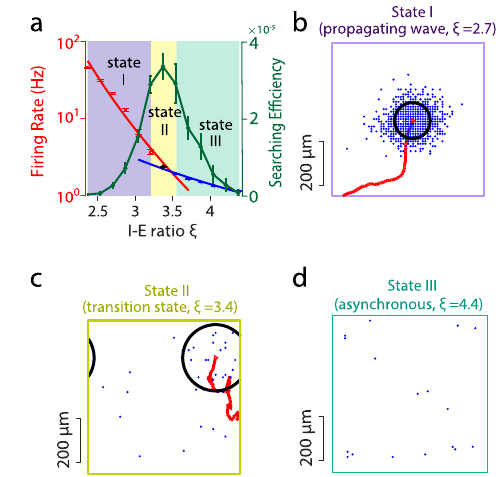
Fig. 4 Emergent network activity in a neural circuit model. a Mean fi ring rate of the population of excitatory neurons in the model shows a phase transition around an I-E ratio of 3.4. The red and blue lines are two power functions fi tted to the data points marked by red squares and blue circles, respectively. The black dot denotes the crossing point of the two power-law functions. The green line shows the change of the searching ef fi ciency with different I-E ratios. Error bars show SEM. Three distinct states emerging from the circuit are marked by different colors; State III corresponds to the asynchronous state, State I exhibits localized propagating wave patterns and State II is the transition region. b – d Snapshots of neural spiking patterns emerging from the circuit model with different I-E ratio values. Blue dots denote spikes emitted by excitatory neurons during a 5 ms period. Black circles in ( b ) and ( c ) show one standard deviation of the 2D normal fi tted fi ring rate. Red curves show trajectory of the pattern in the previous 100 ms. For State I in ( b ), the spiking patterns propagate smoothly. For State II in ( c ), the pattern appears intermittently and exhibits variable propagation trajectories. For State III (the asynchronous state) in ( d ), no patterns are